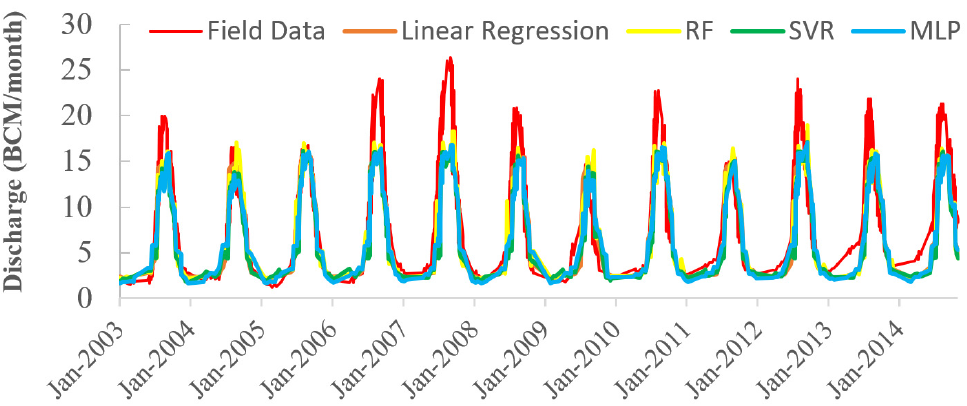
Figure 5. Comparison between field data and bias-corrected data using RF, SVR, and MLP methods at Dongola station.